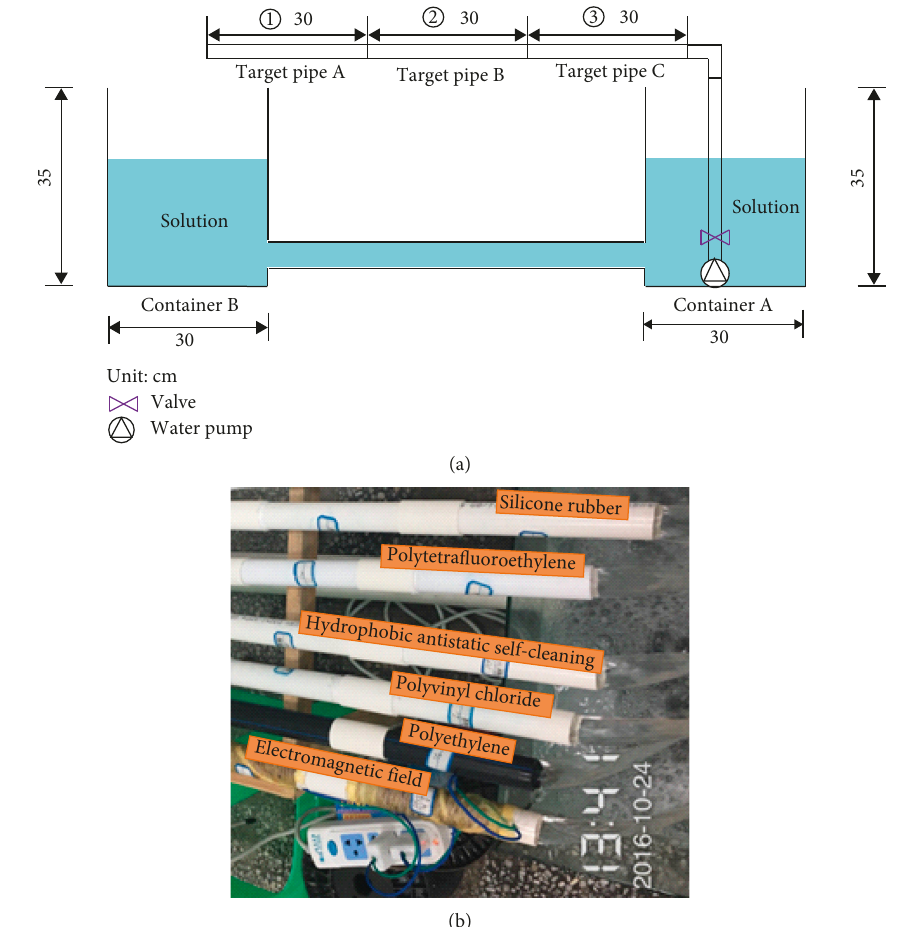
Figure 4: Experimental system. (a) Laboratory experimental system. (b) Experimental system in